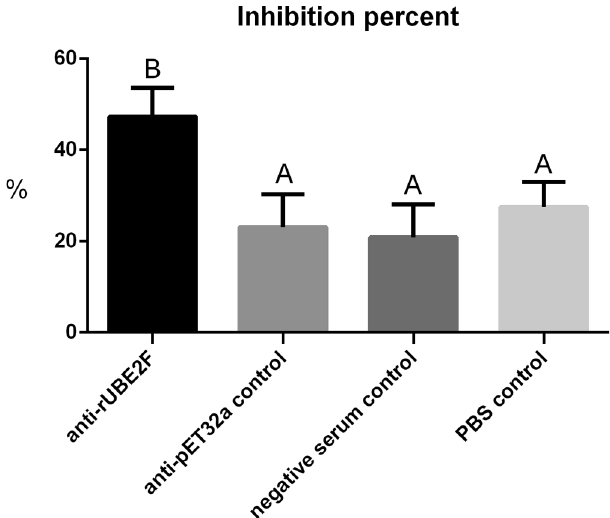
Figure 6. The inhibition of Eimeria acervulina sporozoite invasion by chicken antisera against rUBE2F. The inhibitive ratio was calculated and expressed as mean ± SD . In each column there is a signi fi cant difference ( p < 0.01) between means and ranks with different letters, and no signi fi cant difference ( p > 0.05) between means and ranks with the same